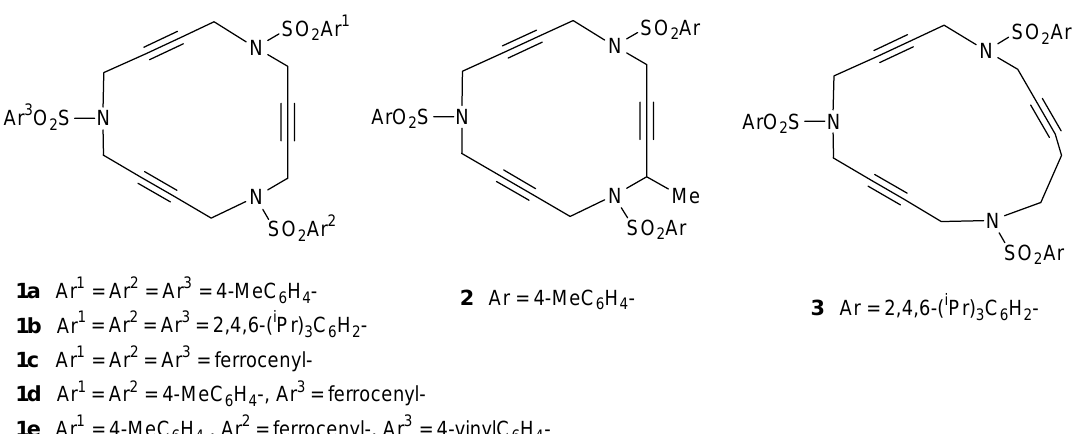
Figure 1. Triacetylenic